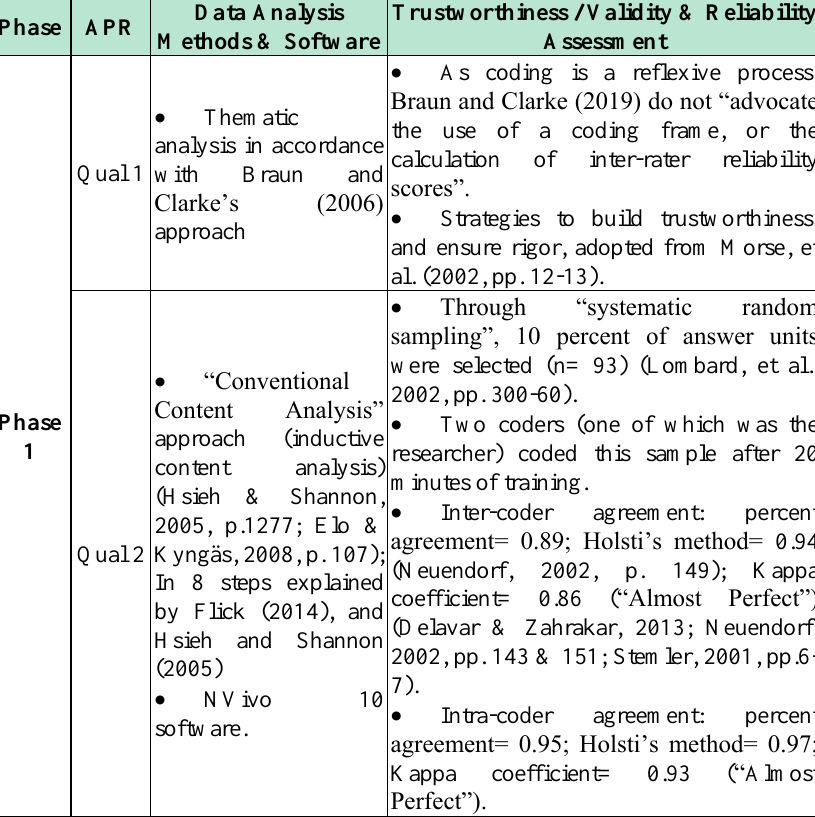
Table 3: Data Analysis